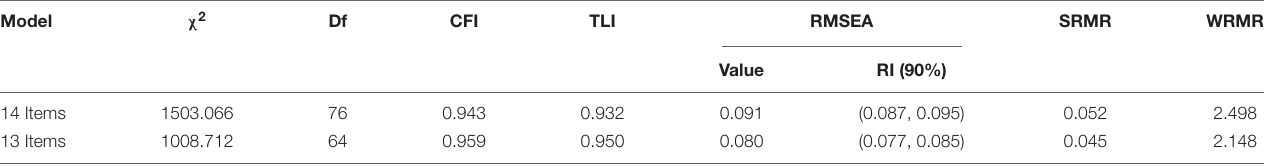
TABLE 4 | Fit indices of the models evaluated by CFA of the study